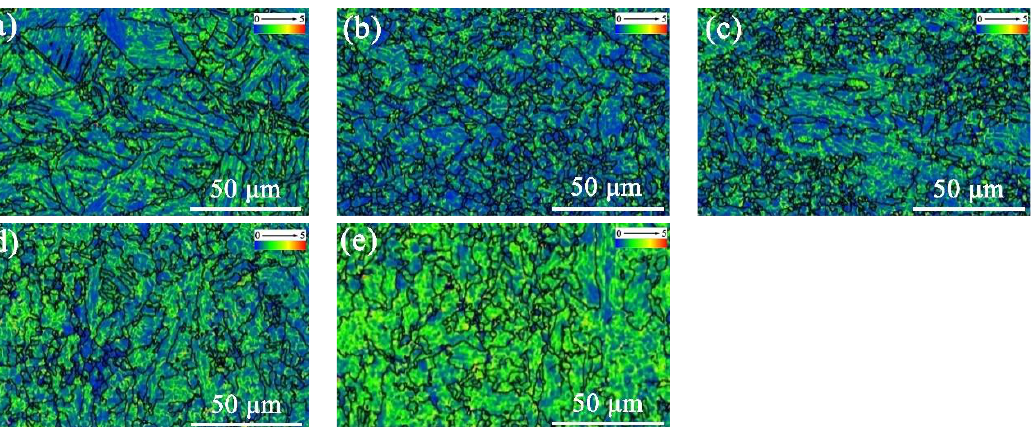
Figure 5. Local misorientation maps of actual welded joints: ( a ) CGHAZ; ( b ) FGHAZ; ( c ) ICHAZ; ( d ) SCHAZ; ( e ) base metal.